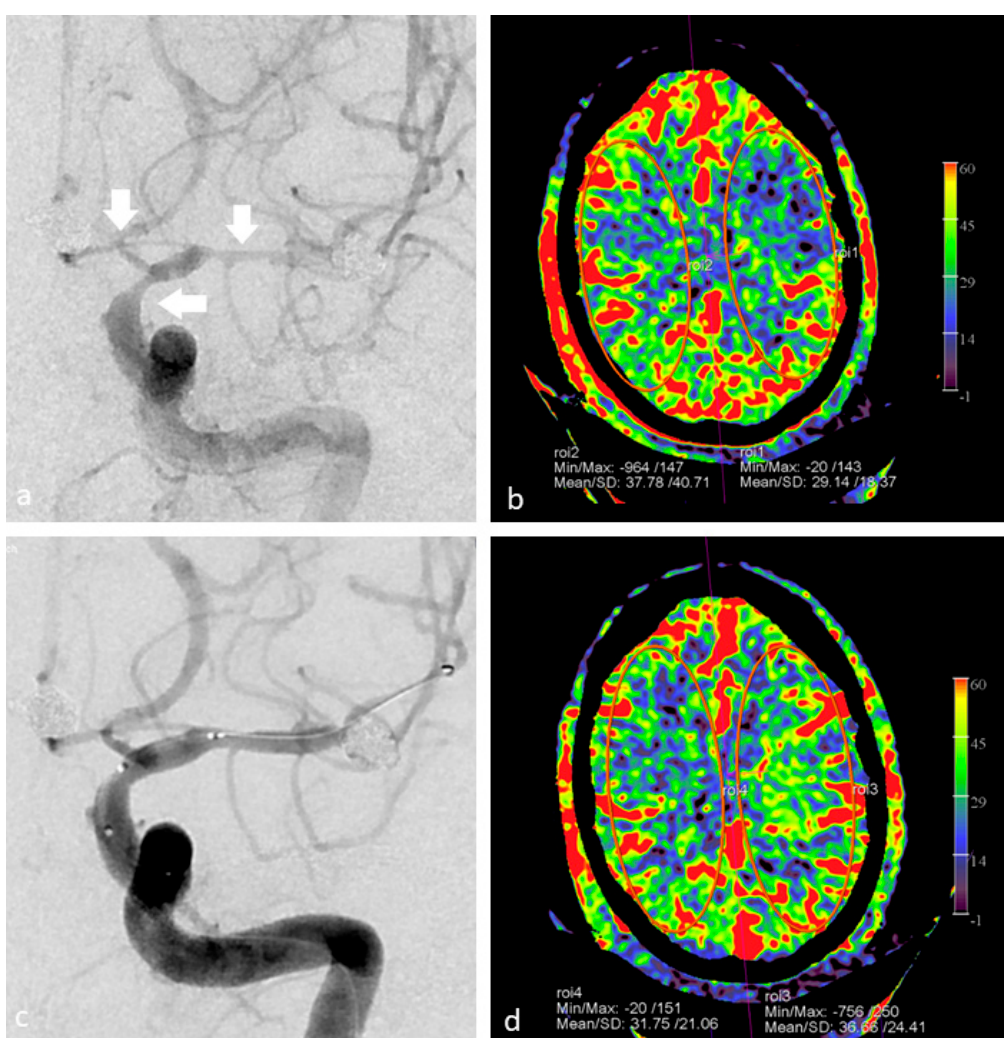
Figure 9. FD CT PBV imaging in a 44-year-old patient after subarachnoid hemorrhage with symptomatic vasospasm. ( a ) DSA in AP view demonstrates severe vasospasm at the level of the left distal internal carotid artery, proximal anterior and middle cerebral arteries (white arrows). ( b ) FD CT PBV mapping with PBV measurements before EVT, displaying lower PBV values at the left hemisphere, compared to the right hemisphere. ( c ) DSA image post dilatation shows favorable angiographic response to PTA. ( d ) Post PTA FD CT PBV measurements show improvement of the PBV value at the left hemisphere compared to the right hemisphere.